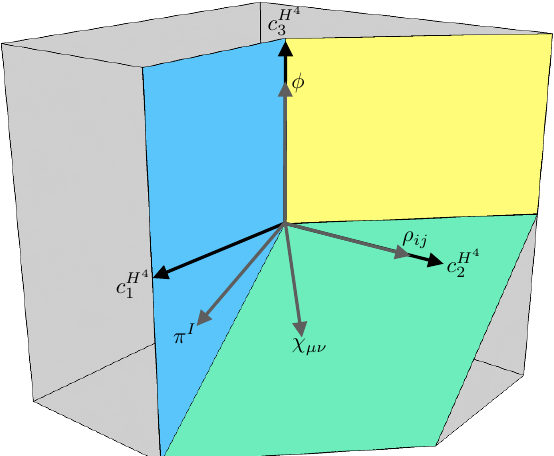
Figure 8 . Bounds on the three ( DH ) 4 operator coe(cid:14)cients from eq. (4.30): c H 4 c H 4 + c H 4 > 0 (yellow), and c H 4 + c H 4 + c H 4 > 0 (green). Gray arrows indicate the vectors of 1 2 1 2 3 Wilson coe(cid:14)cients generated in example tree-level completions, all lying in the interior or on the boundary of the allowed space, with various massive states coupling to ( DH ) 2 : a scalar singlet (cid:30) , scalar triplet (cid:25) I , bifundamental scalar (cid:26) ij , and symmetric spin-two (cid:12)eld (cid:31) (cid:22)(cid:23) . The forbidden region is shaded in